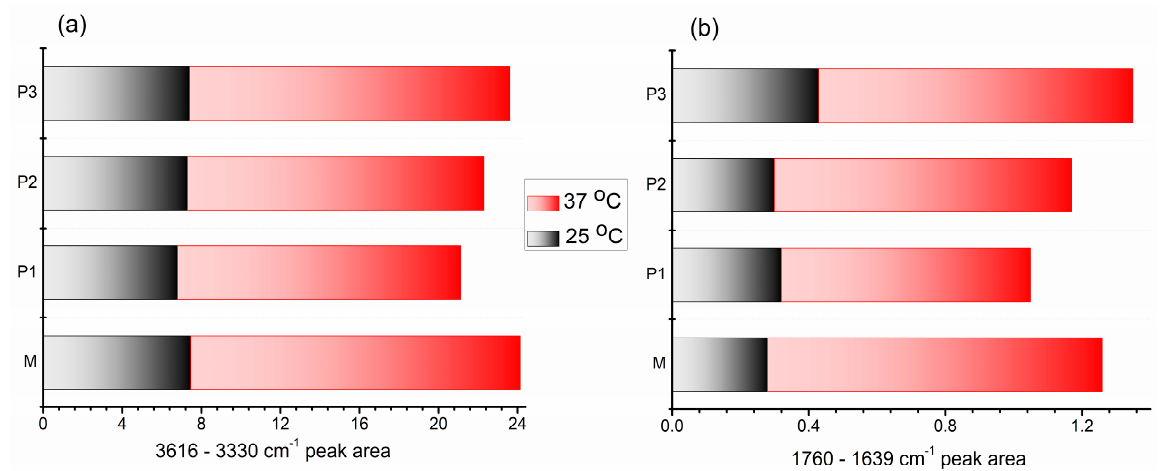
Figure 5. Variation of the peak area between ( a ) 3616 and 3330 cm − 1 and ( b ) 1760 and 1639 cm − 1 as a function of increasing temperature for the investigated samples.